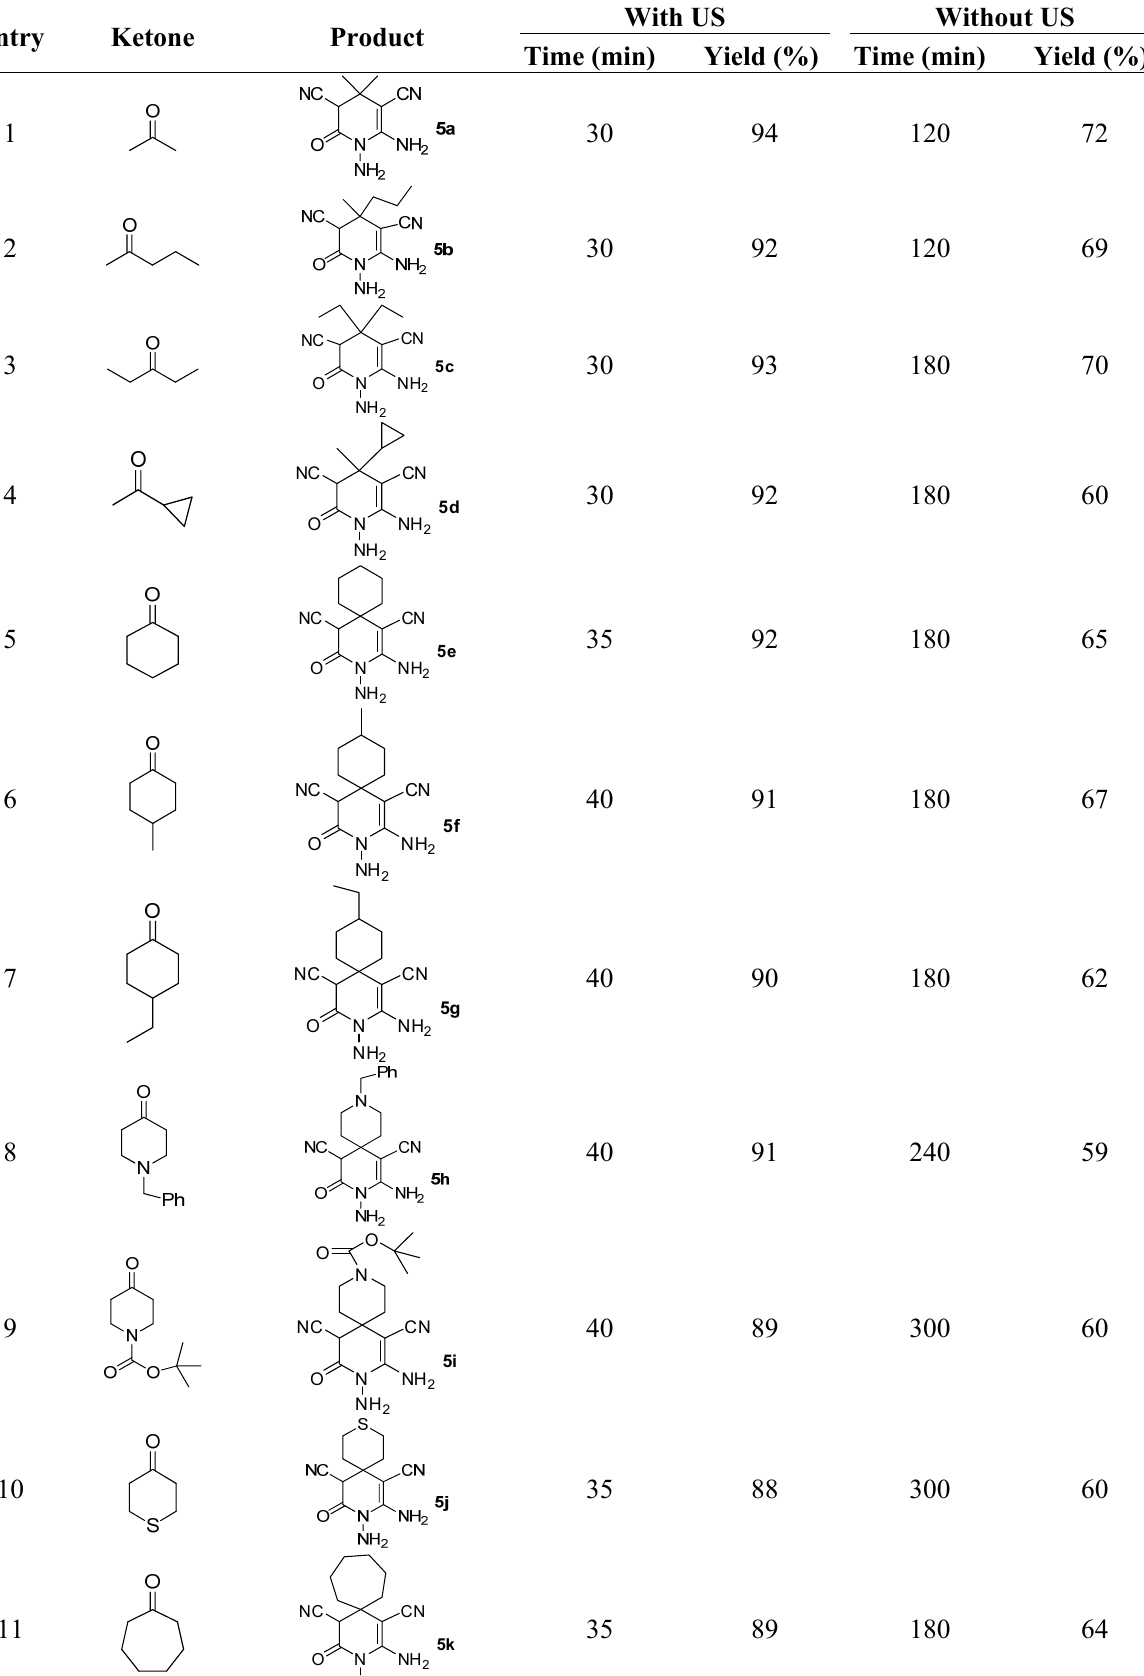
Table 2. Synthesis of pyridin-2( 1H )-one derivatives 5